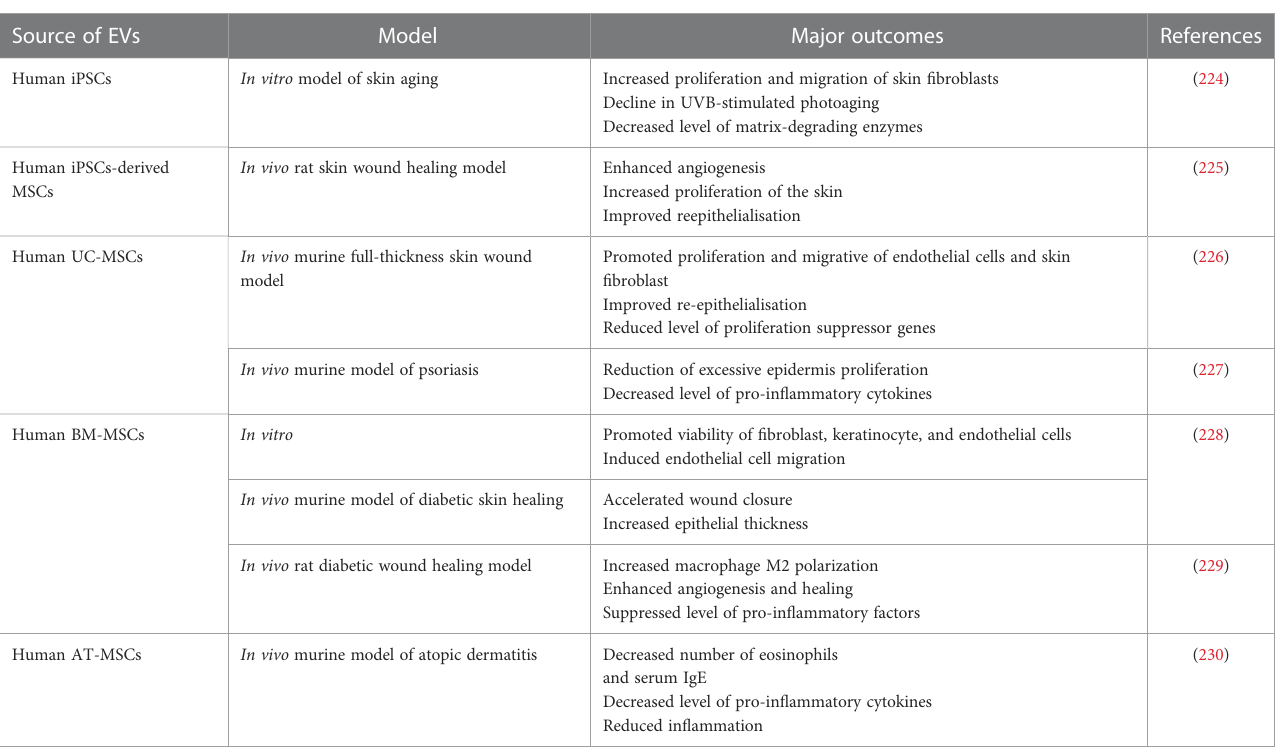
TABLE 7 Examples of EV use in preclinical studies related to the treatment of skin